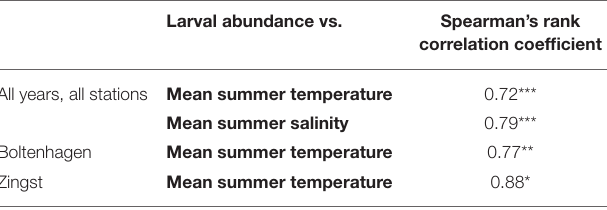
TABLE 2 | Spearman’s rank correlation coefficient for potential influence of seawater temperature and salinity on the abundance of Teredo navalis on the Mecklenburg-western Pomeranian